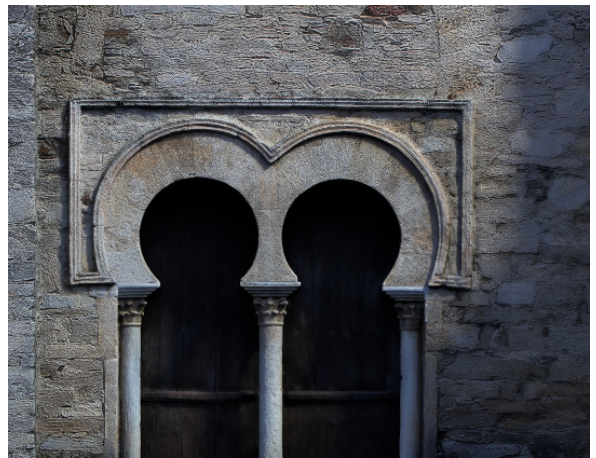
Figure 16: Door of Santiago de Pe˜nalba, Leon, Spain. Detail of the orthoimage(down) with slightly different slanted illumination to highlight relief details.